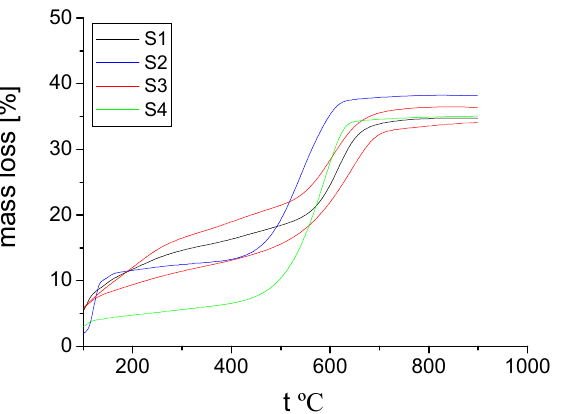
Figure 6. Mass loss (%) that resulted from TGA in nitrogen for hybrid compounds S1 – S4 .